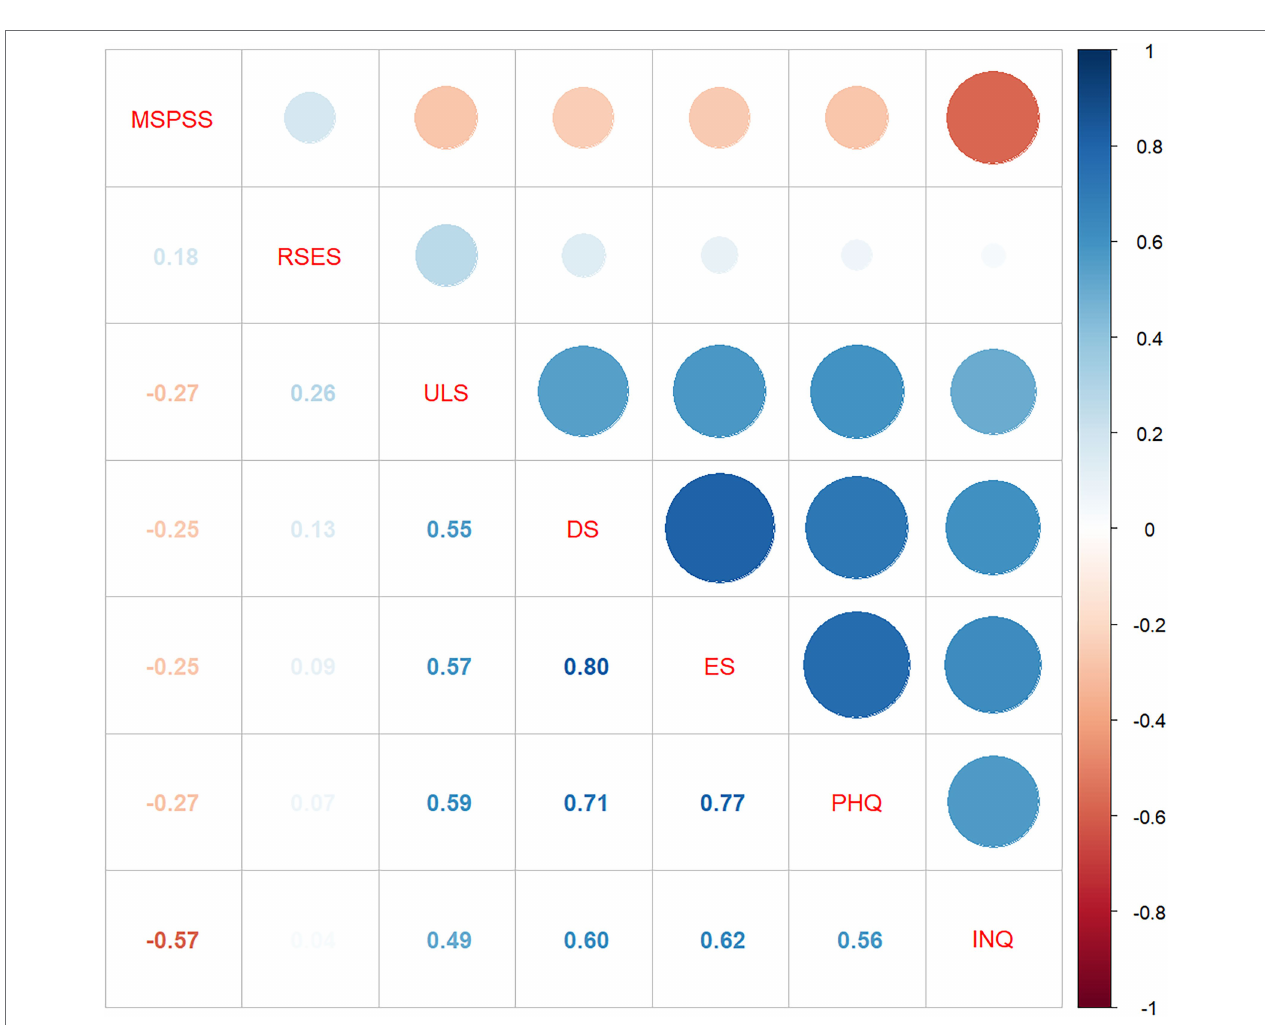
FIGURE 1 | Inter-correlations among psychosocial